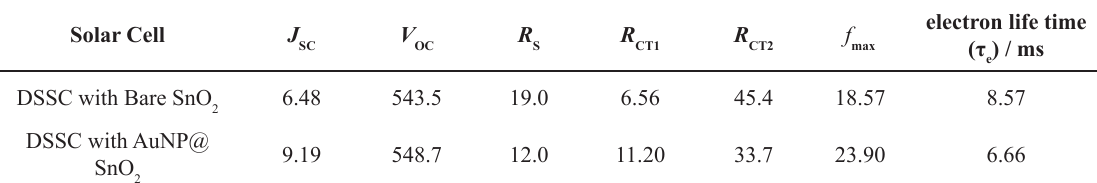
Table 2: Interfacial photoelctrochemical resistances and electron life time from EIS measurements of DSSCs made from two different SnO –based 2